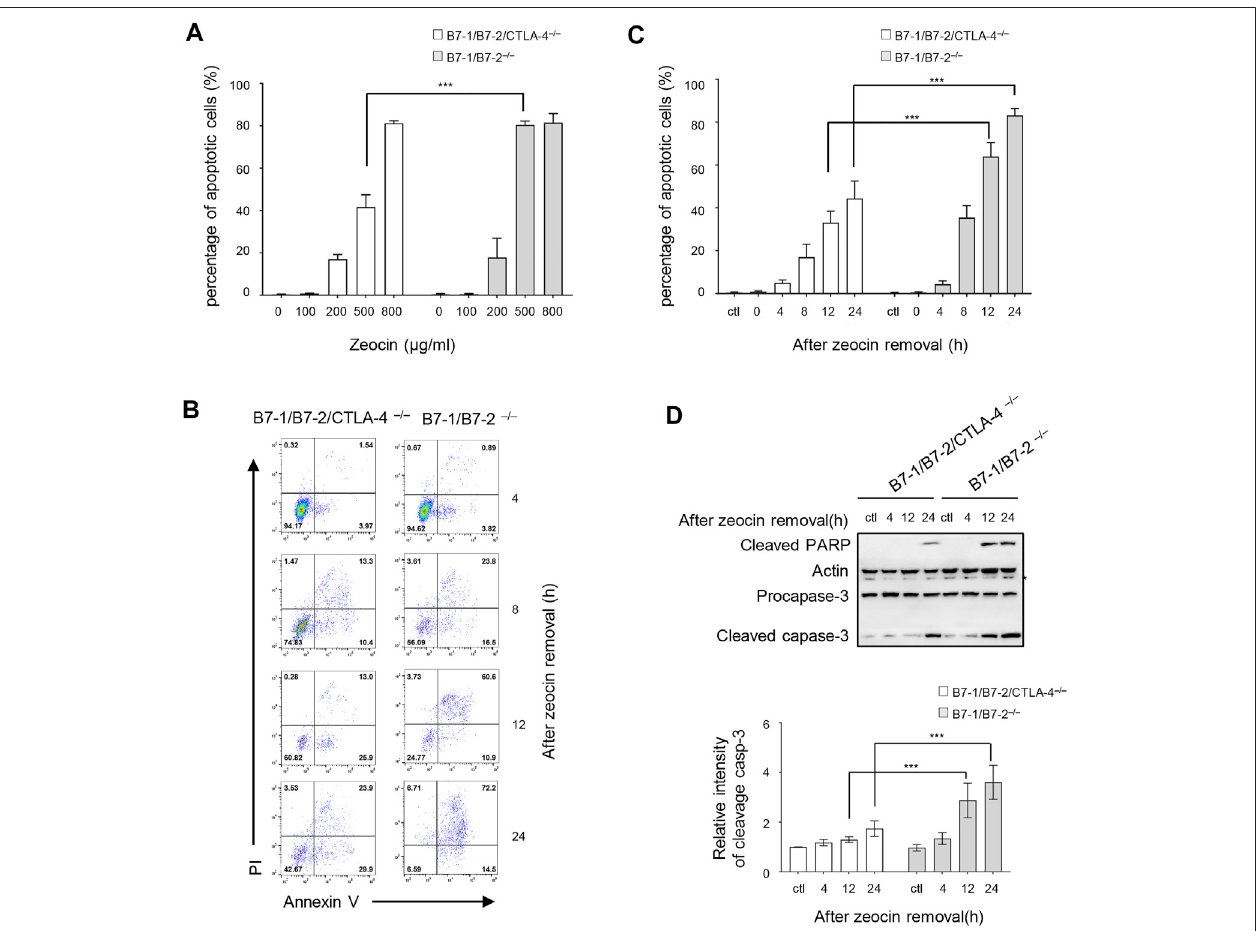
FIGURE 1 | CTLA-4 increases the risk of T cells undergoing DNA damage – induced apoptosis. (A) Percentage of apoptotic cells (Annexin V-positive stained cells). CD4 + TcellsfromB7-1/B7-2 − / − andB7-1/B7-2/CTLA-4 − / − miceweretreatedwith100,200,500,or800 μ g/mlzeocinfor1 handthencultured withoutzeocinfor24 h. The cells were collected, and apoptosis was detected. These results are representative of three experiments. All values represent the averages ±SEM of three independent experiments. *** p < 0.001. Ctl indicates untreated control cells. (B) Annexin V-PI dual-staining assay and fl ow cytometry analysis. CD4 + T cells from B7-1/B7-2 − / − and B7-1/B7-2/CTLA-4 − / − mice were treated with 500 μ g/ml zeocin for 1 h, cultured without treatment for the indicated times and collected to detect apoptosis. (C) Percentage of apoptotic cells (Annexin V-positive stained cells) of the cells shown in (B) . These results are representative of three experiments. All values are presented astheaverages±SEMofthree independent experiments. *** p < 0.001. (D) Thelevels ofcleaved PARPand caspase-3 inCD4 + Tcellsfrom B7-1/B7-2 − /